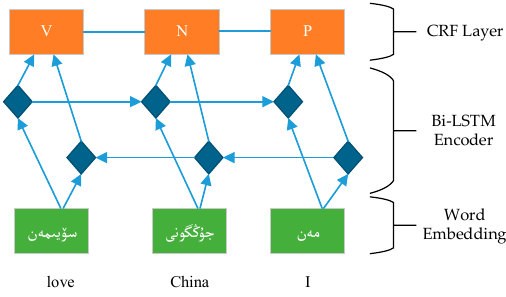
Figure 2. BI-LSTM-CRF model.